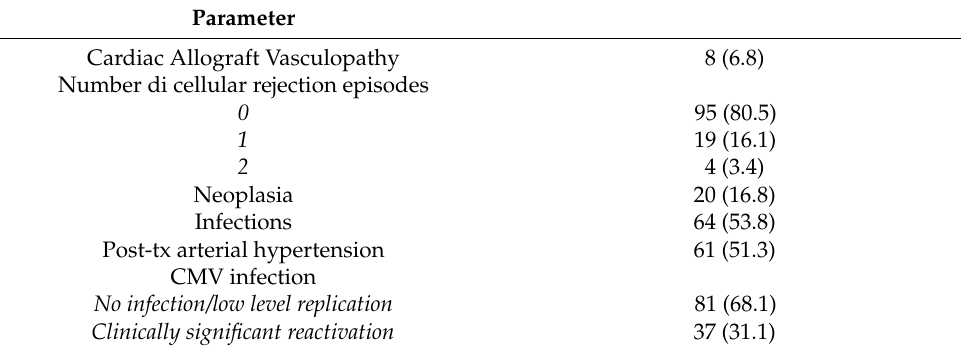
Table 2. Post-transplant cardiovascular and non-cardiovascular outcomes.